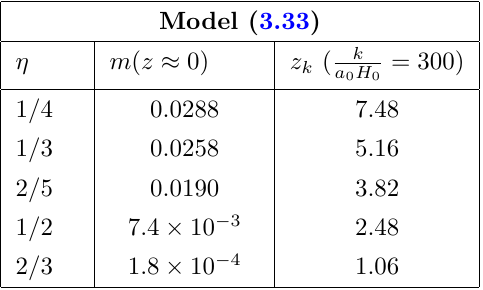
Table 2 . The transition redshift and current values of m for some cases of the model (3.33).